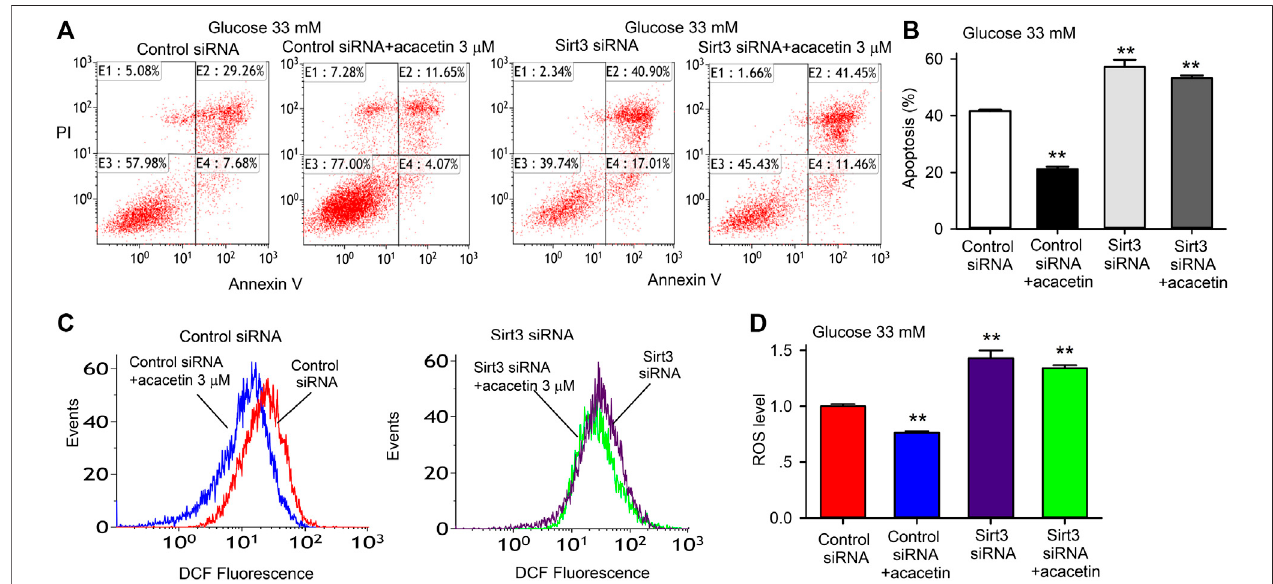
FIGURE 4 | Sirt3 silencing and acacetin effects on apoptosis and ROS production induced by high glucose exposure in HUVECs. (A) Flow cytometry graphs for analyzing apoptosis (E2 + E4) in cells transfected with control siRNA or Sirt3 siRNA and cultured with 33 mM glucose medium in the absence or presence of 3 μ M acacetin. (B) Acacetin decreased apoptosis in cells transfected with control siRNA, but not in cells transfected with Sirt3 siRNA. (C) Flow cytometry graphs for determining ROS levels in cells transfected with control siRNA or Sirt3 siRNA and cultured with 33 mM glucose medium in the absence or presence of 3 μ M acacetin. (D) Acacetin reduced ROS production in cells transfected with control siRNA, but not in cells transfected with Sirt3 siRNA. n (cid:2) 5 individual experiments, ** p < 0.01 vs. control